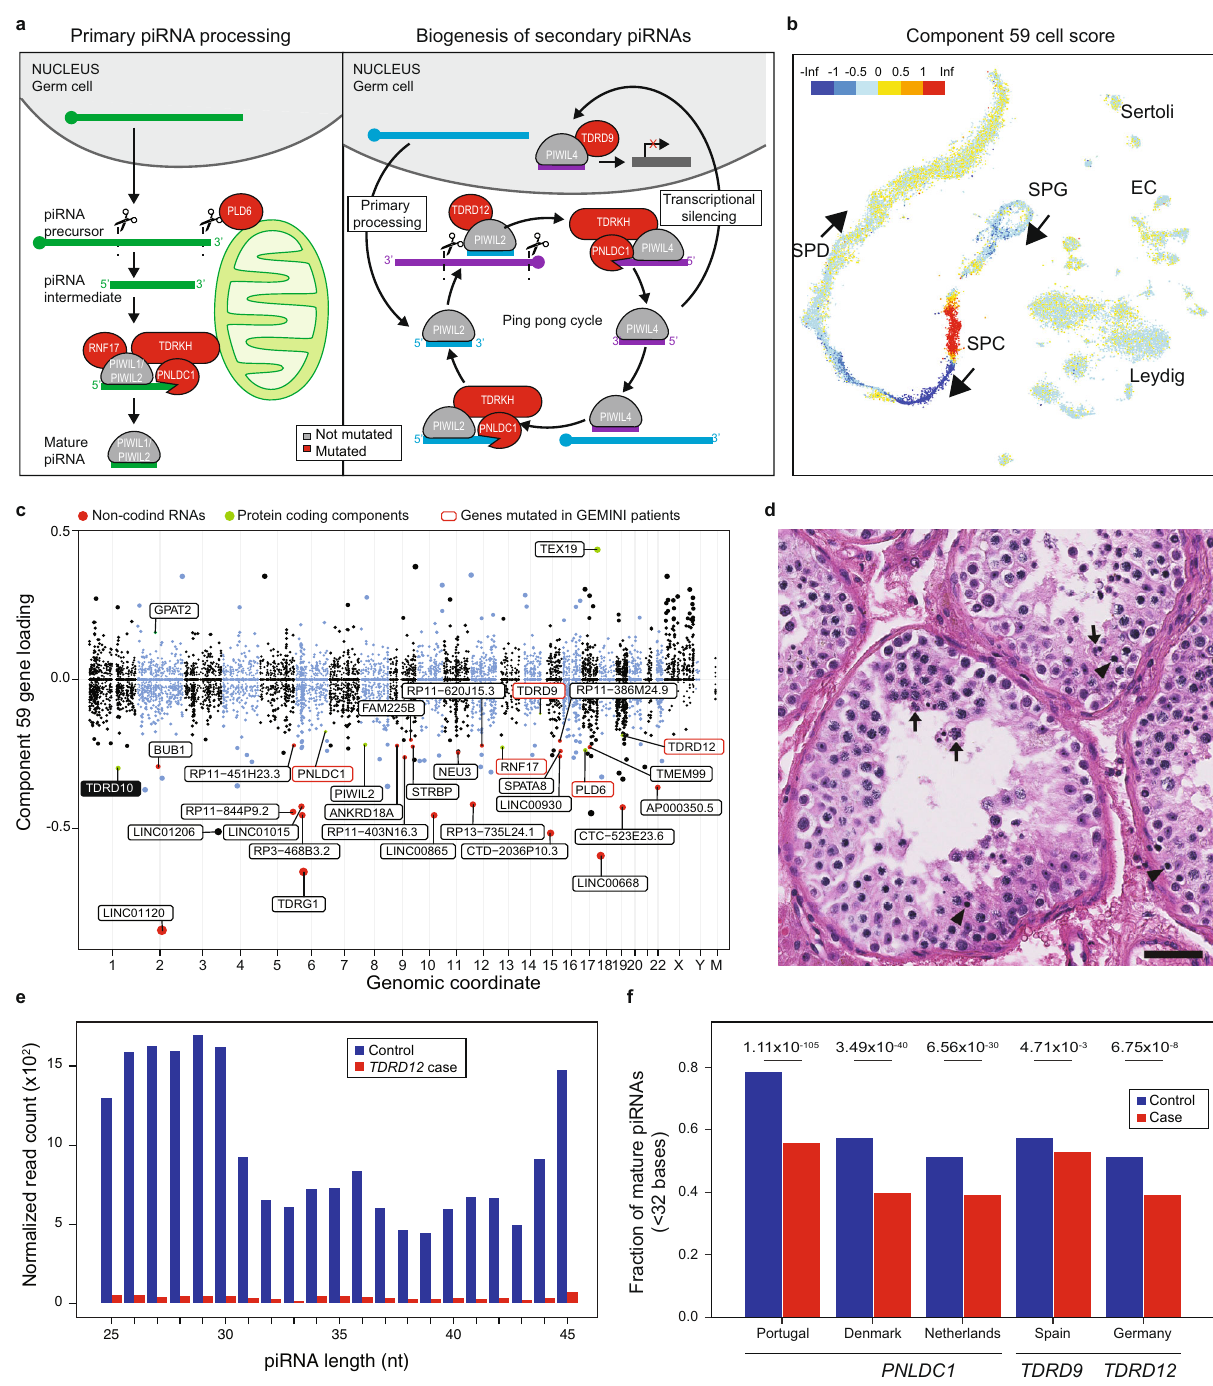
Fig. 6 | Disruption of piRNA biogenesis causes spermatogenic failure in men. a AschematicofpiRNAbiogenesiswiththecomponentsaffectedamongNOAcases in this study highlighted in red. piRNAsare produced by two biogenesispathways. The primary pathway involves transcription of long precursor-transcripts from genomic clusters, which are then processed in the cytoplasm. b Cell scores for component 59, which encodes both piRNA processing genes and target pre-pre- piRNAs, indicate that it is expressed primarily in pre-leptotene spermatocytes. c Gene loadings for component 59. Note TDRD10 (black box), a protein-coding gene that has yet to be characterized for a role in mammalian piRNA processing.